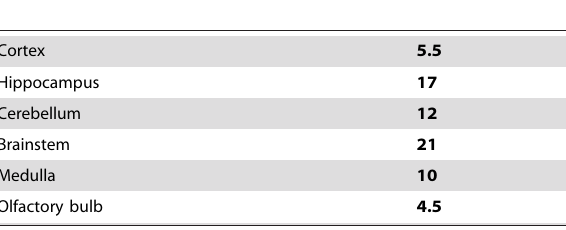
Table 1. Expression levels of PrP C in different brain regions of Tg a 20 relative to C57BL/6